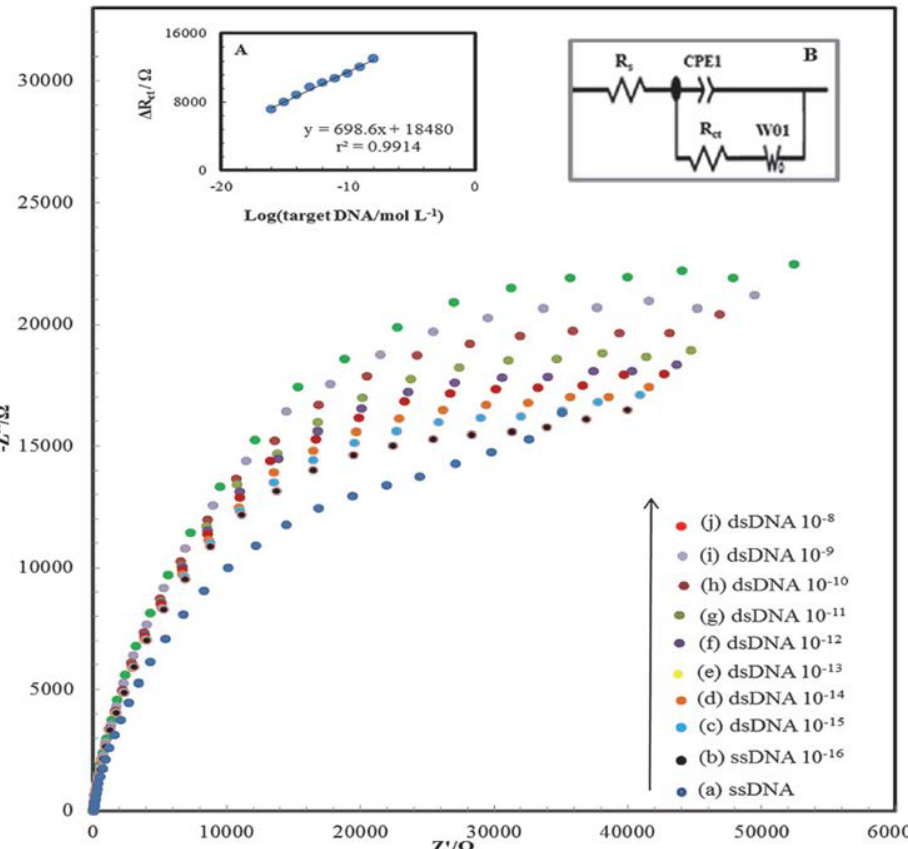
Figure 7. The obtained EIS signals for various concentrations of complementary DNA. Inset A: the applied Randles equivalent circuit, Inset B: the dependence of ΔR ct versus the logC of target (DNA).